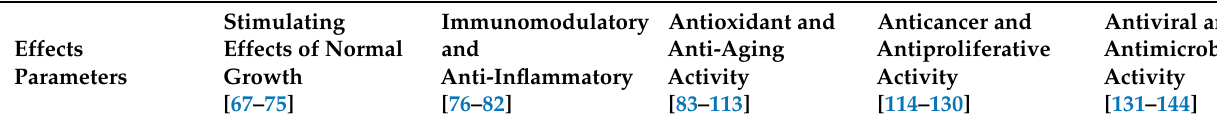
Table 2. Main molecular markers that initiate in the bioactivities of the different pentacyclic triterpenes present in olive extracts and the target cells in which they are